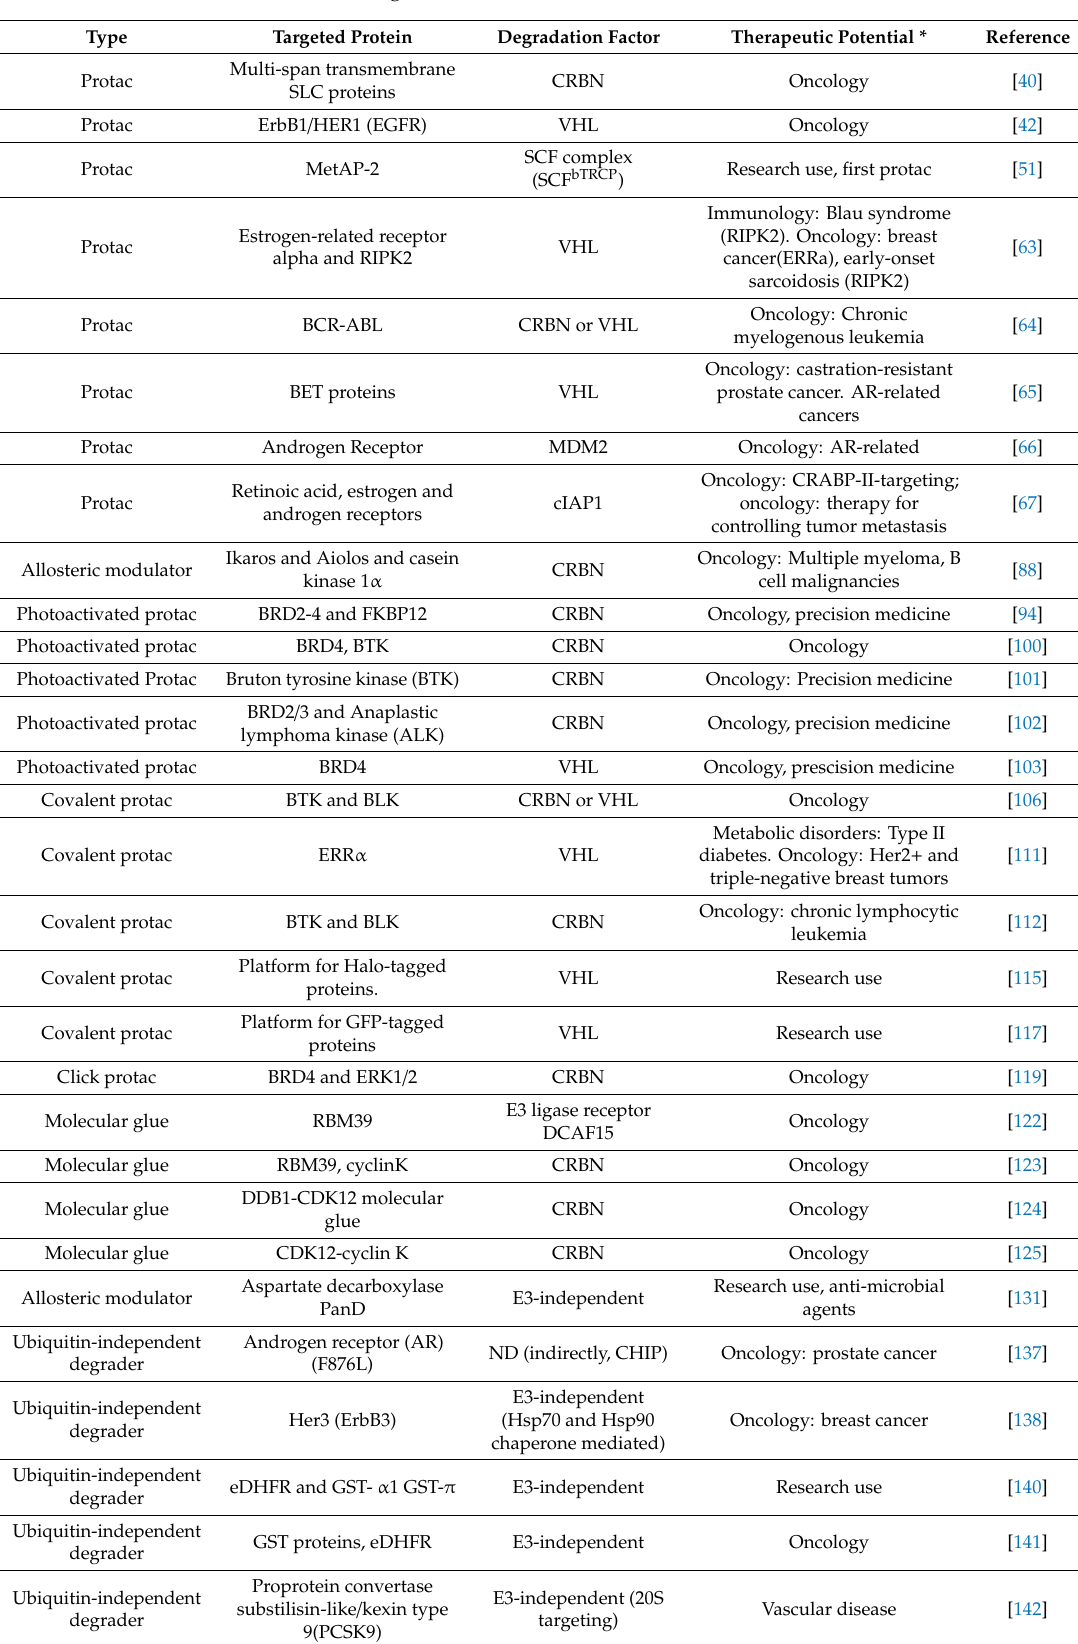
Table 1. Degrader molecules discussed in this